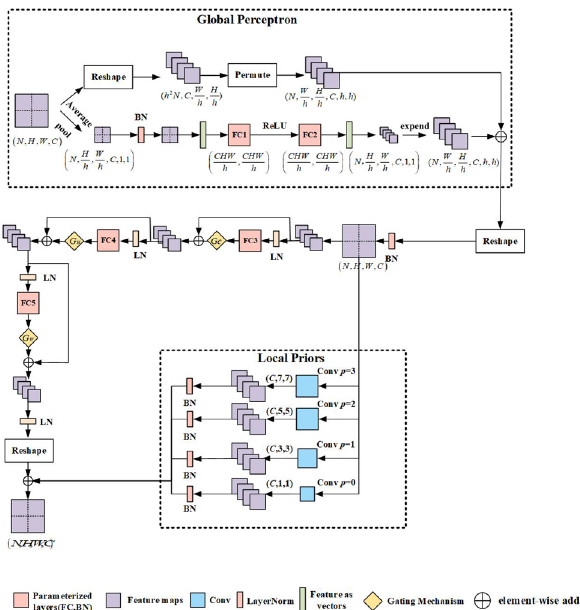
Figure 3. The TGMLP structure is described exhaustively in the figure where N , C , H , and W represent the batch size, channel number, high, and wide of the feature map, respectively, p represents the pixel to be filled, and h represents the size of the segmented area of the feature map. Global Perceptron adds a dependency weight matrix to each partition. Local Priors capture prior local features of feature maps through multiple parallel